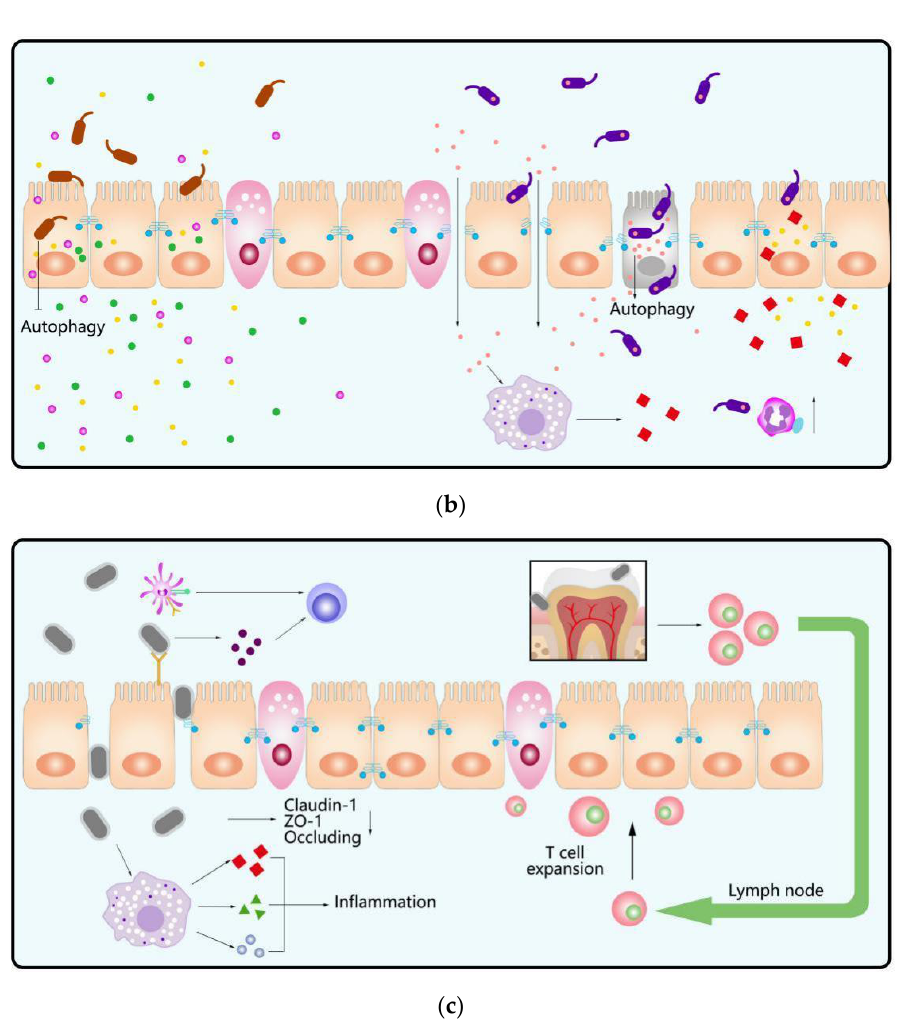
Figure 3. Specific oral pathogenic microorganisms and underlying mechanism patterns in IBD. ( a ) In addition to activating the IL-17F/NF- κB pathway, F. nucleatum can also damage the integrity of intestinal epithelium by regulating the expression and distribution of tight junction proteins zonula occludens-1 and occluding, and promoting proinflammatory cytokine production to exacerbate IBD. P. gingivalis can secrete proteases, gingipains, detaching intestinal mucus by degrading ZO-1,